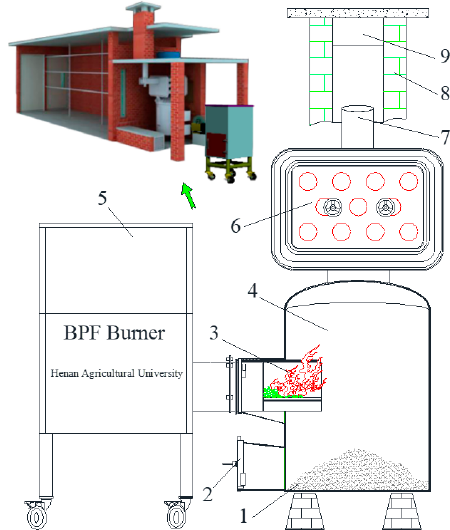
Figure 1. Flowchart of the biomass combustion test in tobacco-heating equipment: 1. piled ash; 2. ash-clearing door; 3. furnace; 4. combustion chamber for heating tobacco; 5. pellet box of burner; 6. radiator; 7. gas exhaust port of radiator; 8. chimney of bulk curing barn; 9. sampling port.